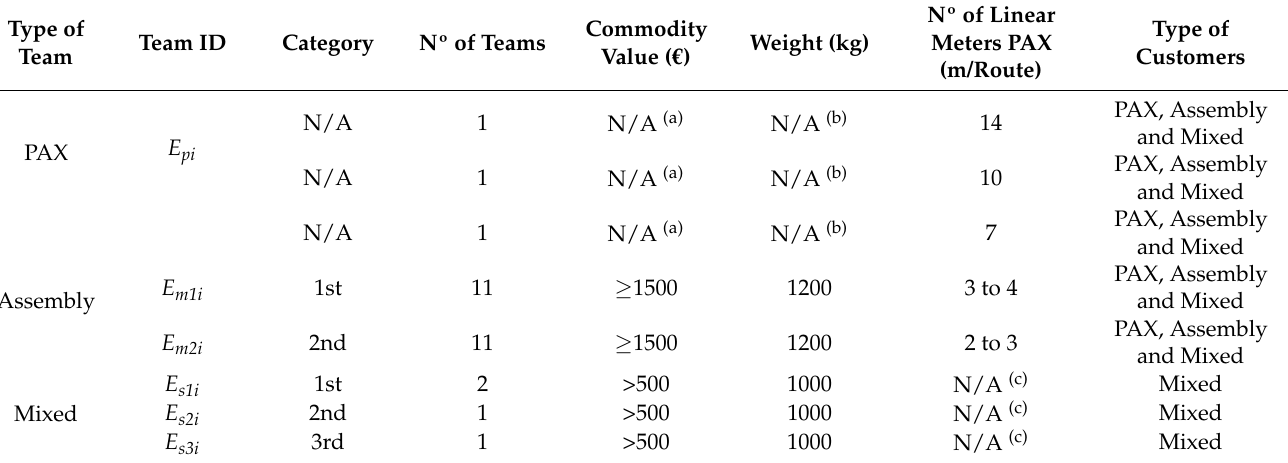
Table 3. Teams classification and